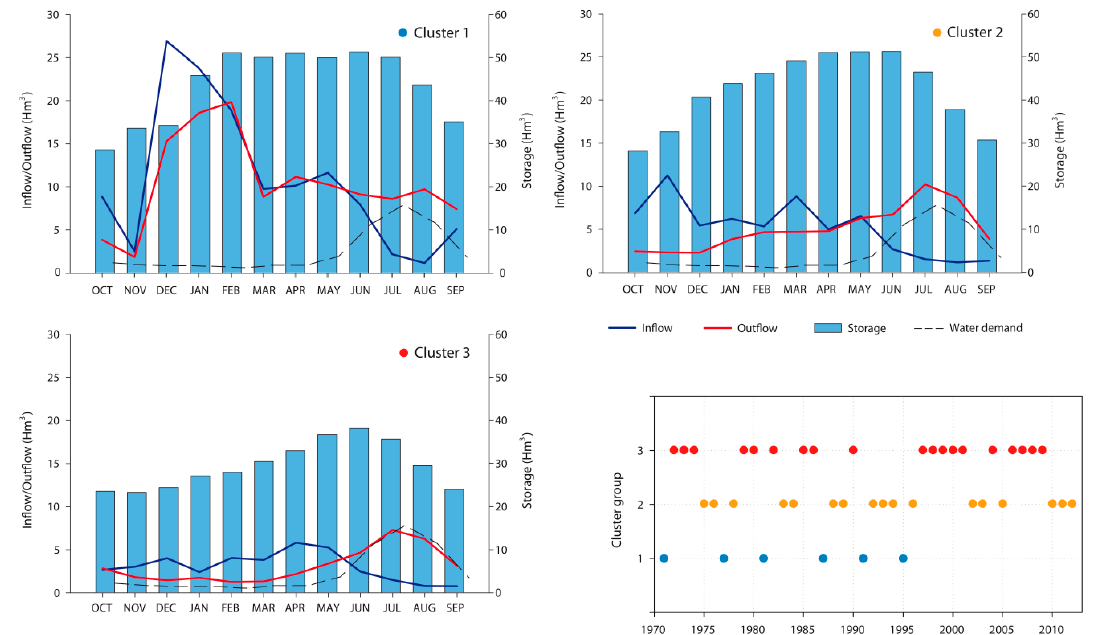
Figure 9. Relationship between Boadella–Darnius dam management strategy and annual and seasonal rainfall observed during the study period (Clusters 1, 2, and 3). Blue line: inflow; red line: outflow; light blue bars: storage; black dashed line: mean monthly water demand regime (2002–2011). Time sequence of the different cluster groups representing dam management strategies (down right).